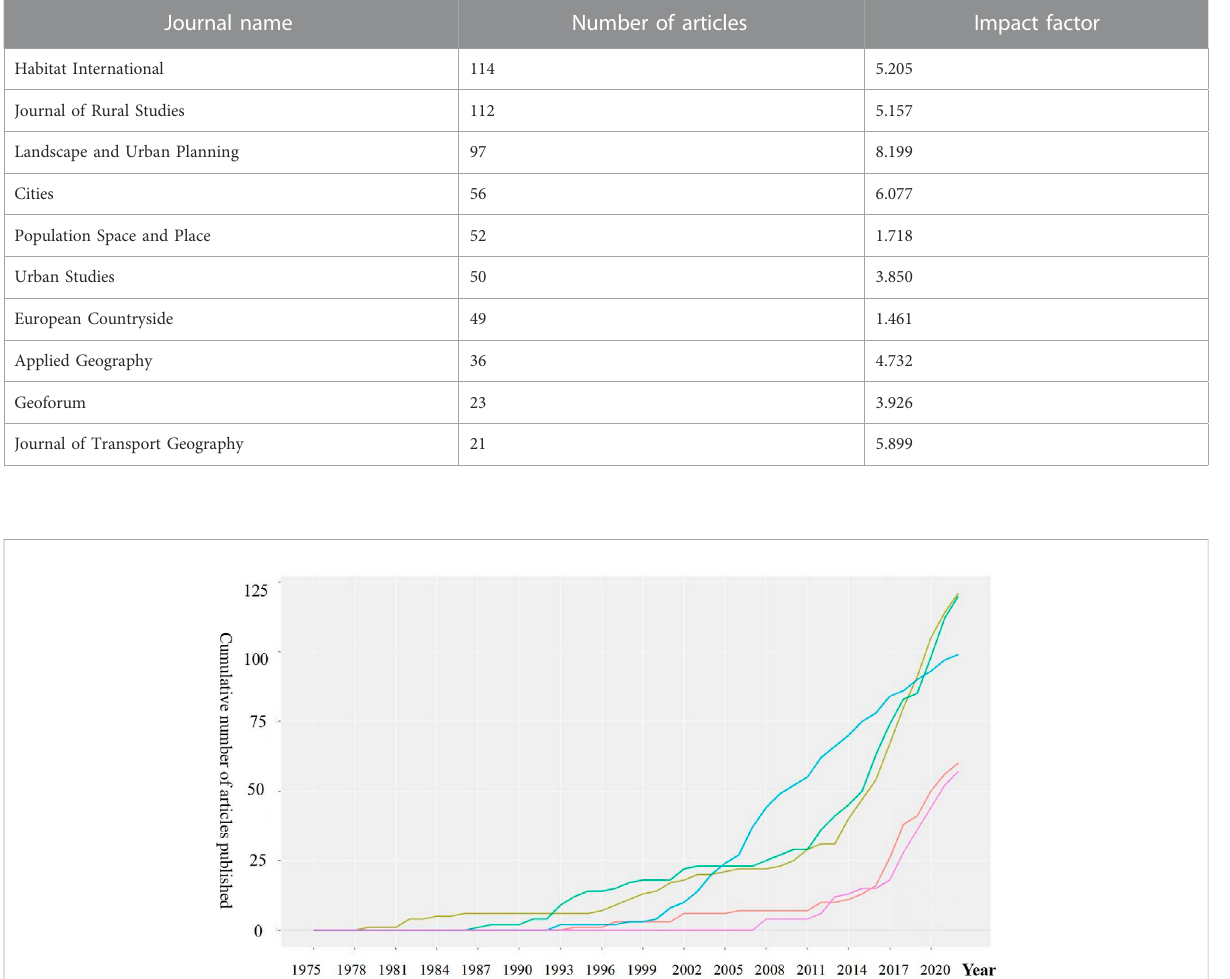
TABLE 1 Top 10 LCS literatures in the fi eld of rural settlements.